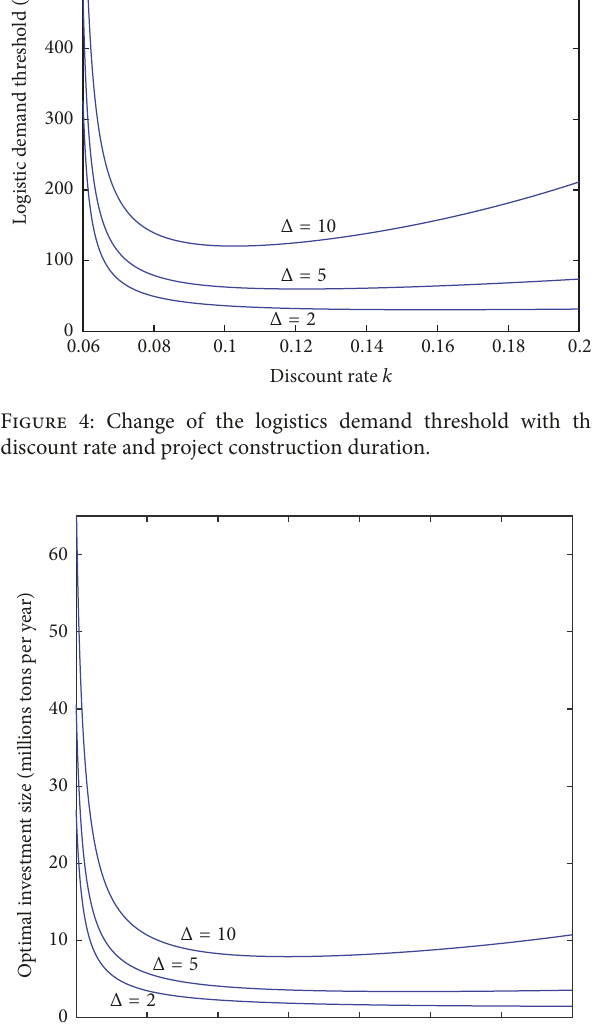
Figure 7: Change of the optimal size with government